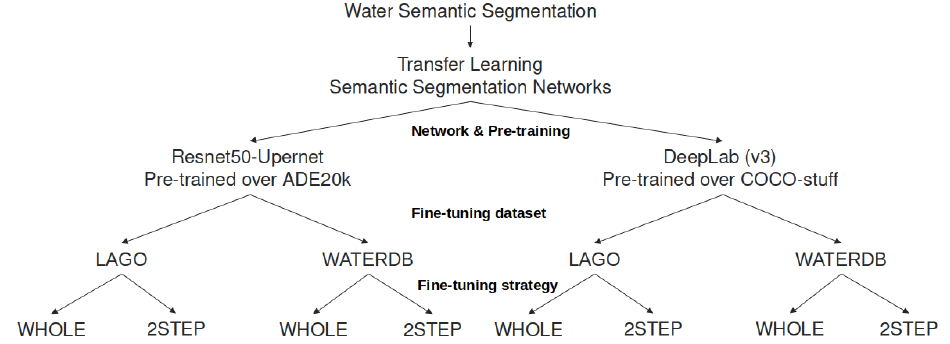
Figure 3. Model configurations used with the TL